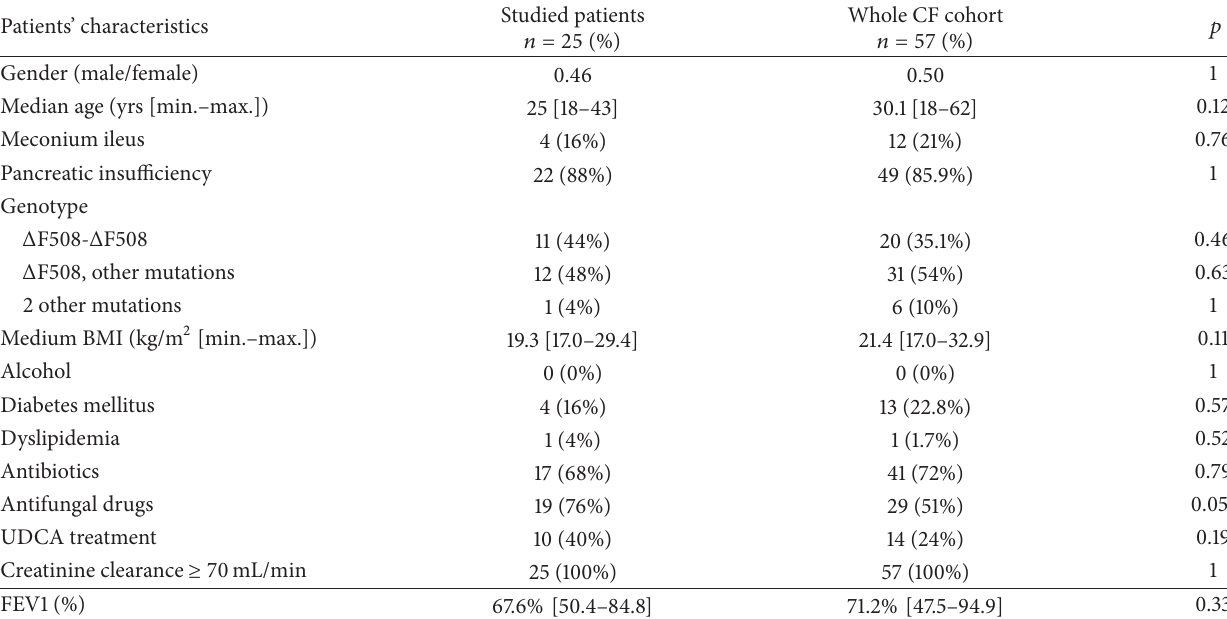
Table 1: Patients’ characteristics at study enrolment.